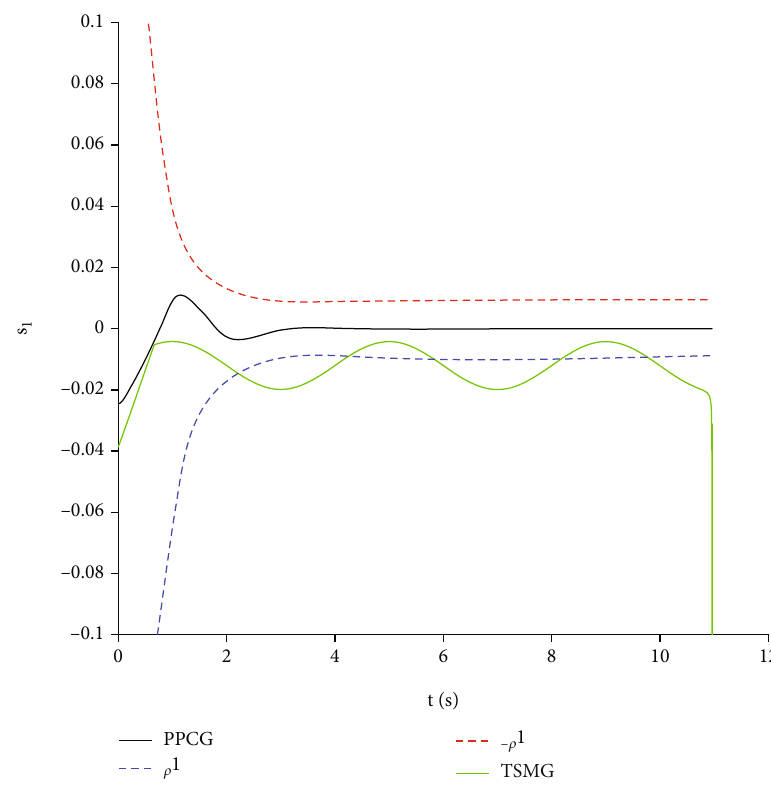
Figure 16: Comparison of slip surface